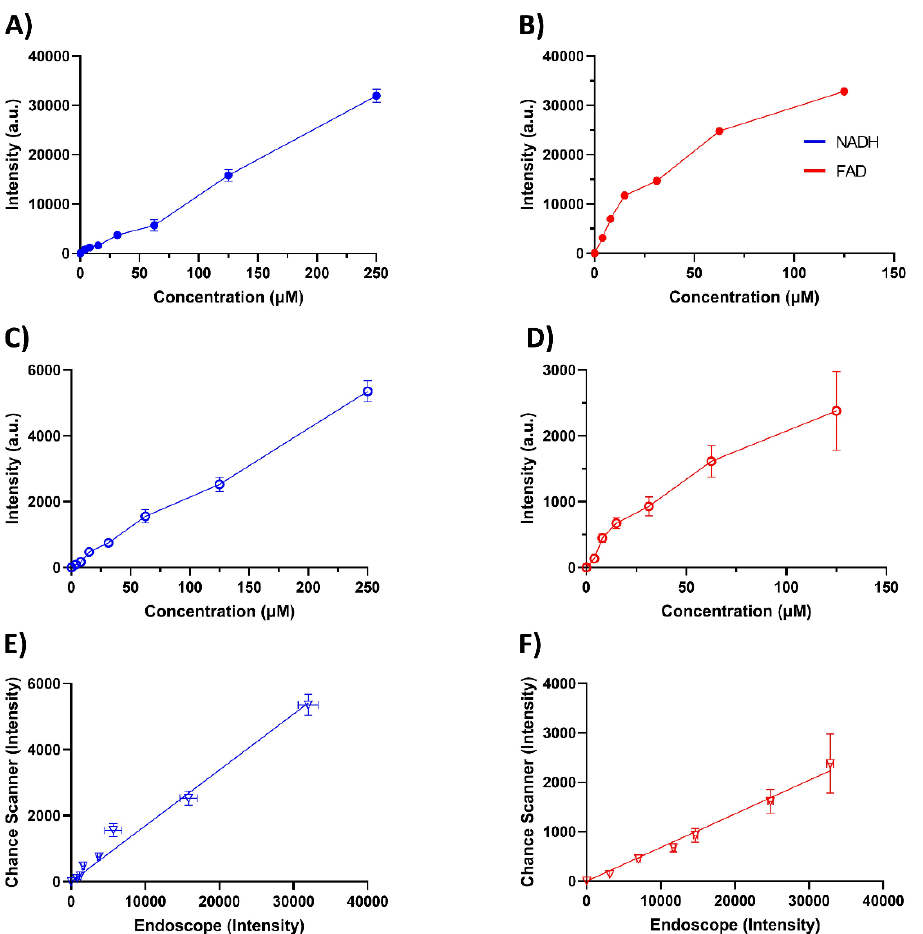
Figure 5. Endoscope and Chance scanner comparison using the NADH and FAD phantom matrices. ( A ) NADH and ( B ) FAD signals of the endoscopic imaging systems are displayed: ( C ) NADH and ( D ) FAD signals were obtained from the same phantom standards using the Chance scanner: ( E ) and ( F ) are the cross-comparisons between the endoscope and the Chance scanner. All blue lines denote NADH plots and red lines denote FAD plots. In addition, closed circles ( • ) denote signals obtained using the endoscope and open circles ( ◯ ) denote signals obtained using the Chance scanner. Triangles ( ∇ ) represent the cross-comparison